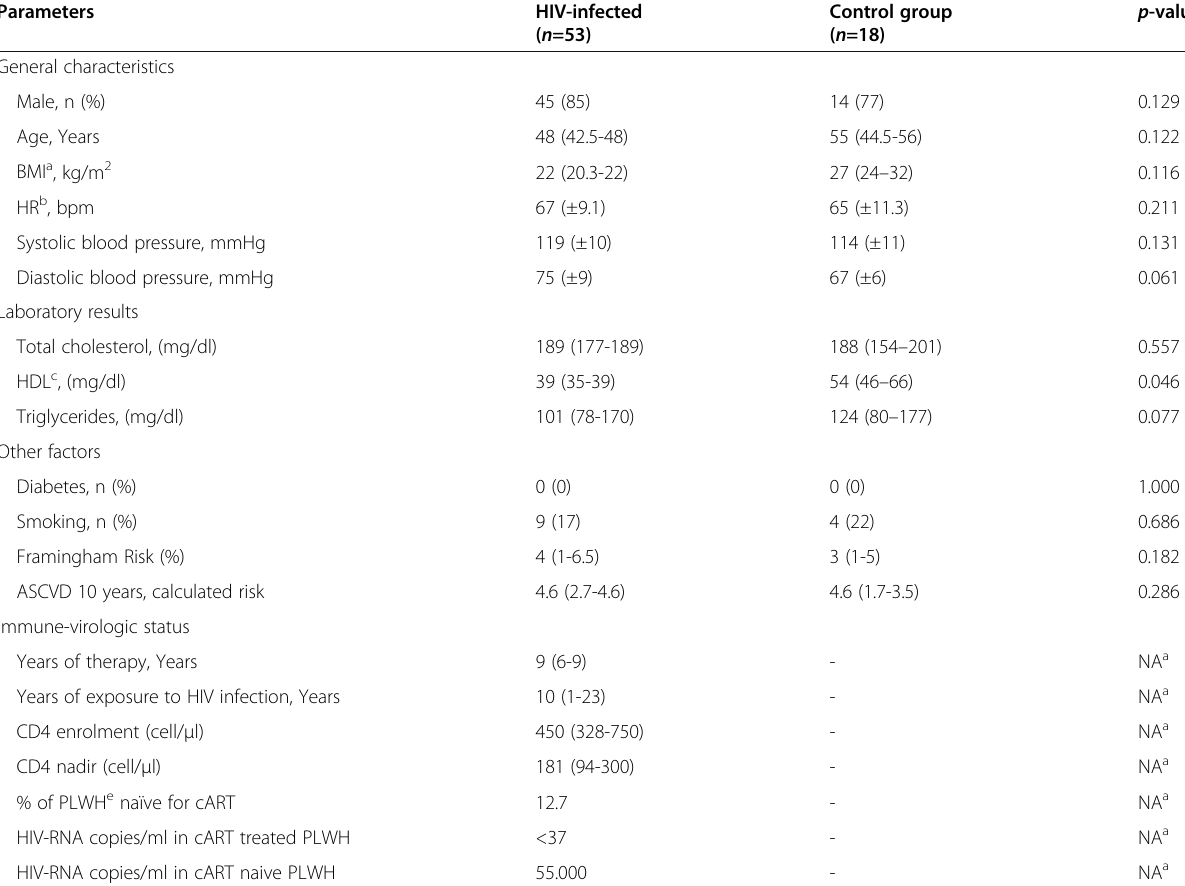
Table 1 Baseline characteristic of the study cohort. Median and interquartile range (IQR: 25%-75%) or mean ± SD are reported for continuous variables. Simple frequencies (n) and percentages are reported for categorical variables. Abbreviations: BMI a , Body